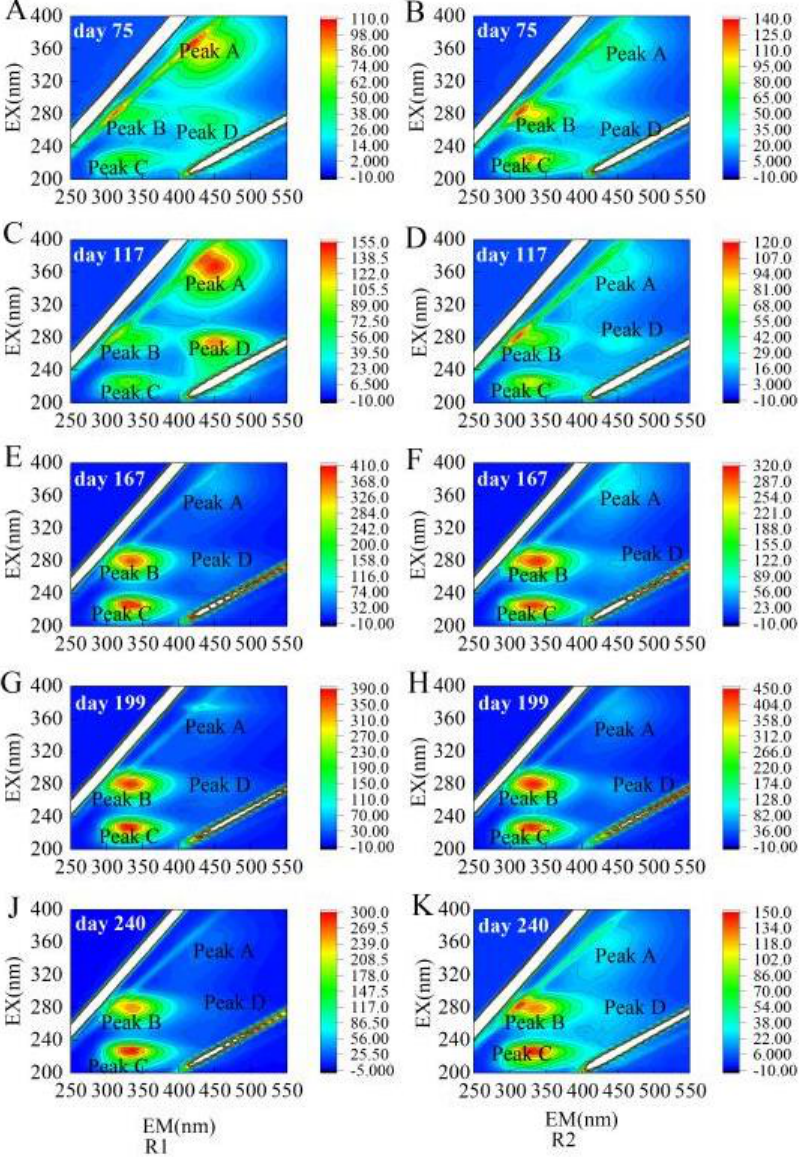
Figure 7. EEM spectra for LB − EPS of aerobic granular sludge in R1 and R2. ( A , C , E , G , J ) for R1; ( B , D , F , H , K ) for R2 .